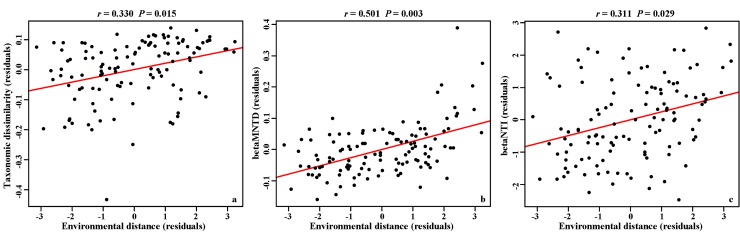
Partial correlation between environmental heterogeneity (environmental distance) and taxonomic dissimilarity (a); and betaMNTD (b); and betaNTI (c).Residuals of the x and y variables are plotted in order to account for the effects of vertical distance and spatial autocorrelation. Solid lines represent linear regressions and the significance levels are determined by partail Mantel tests (9999 permutations).